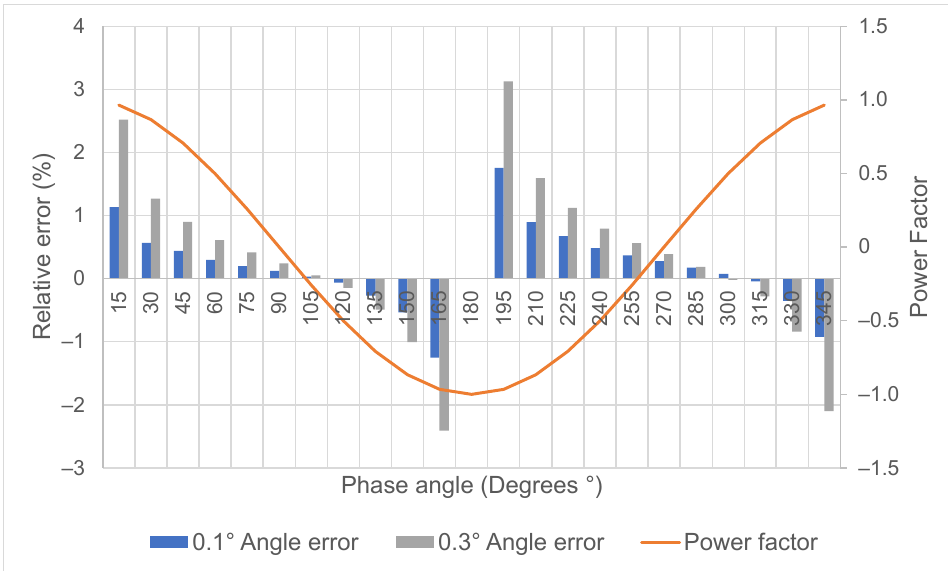
Figure 10. Total reactive power relative error versus phase